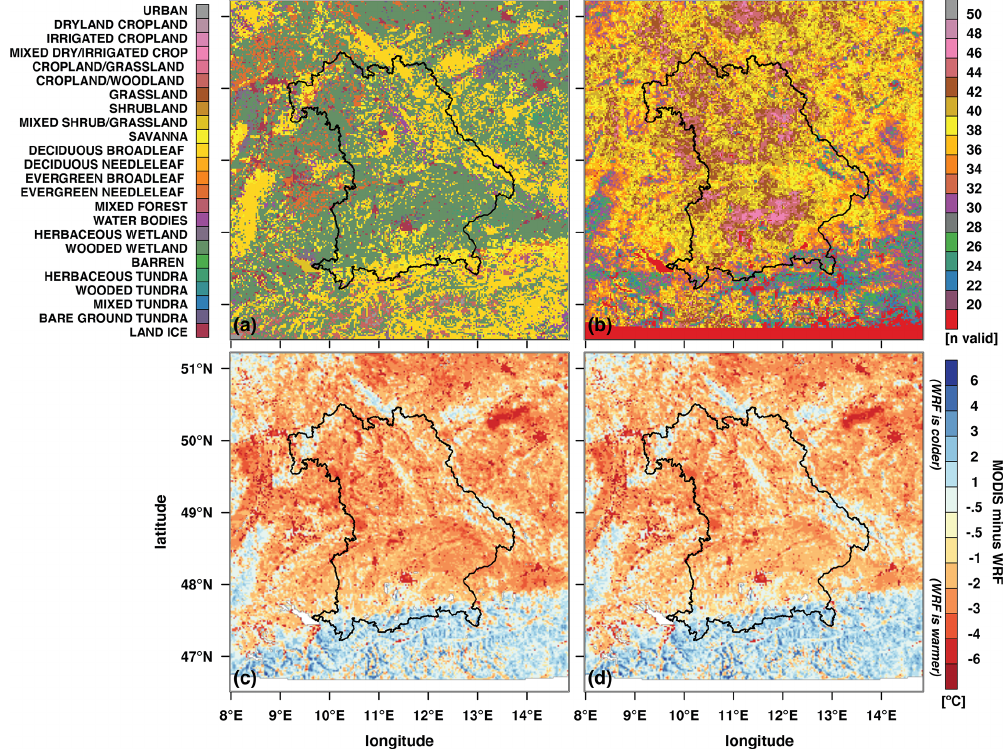
Figure 7. (a) Land use classification in D2. (b) Number of time steps with valid night-time LST data in the MODIS MYD11A1 dataset between 1 June and 31 August 2018 out of a maximum of 52 with less than 50% missing data in D2. The average difference in observed and simulated LST for (c) WRF_NO_NUDGE and (d) WRF_NUDGE. Note that the orange and red colours in panels (c) and (d) shade areas where WRF is warmer than MODIS (MODIS minus WRF is negative) and vice versa for blue